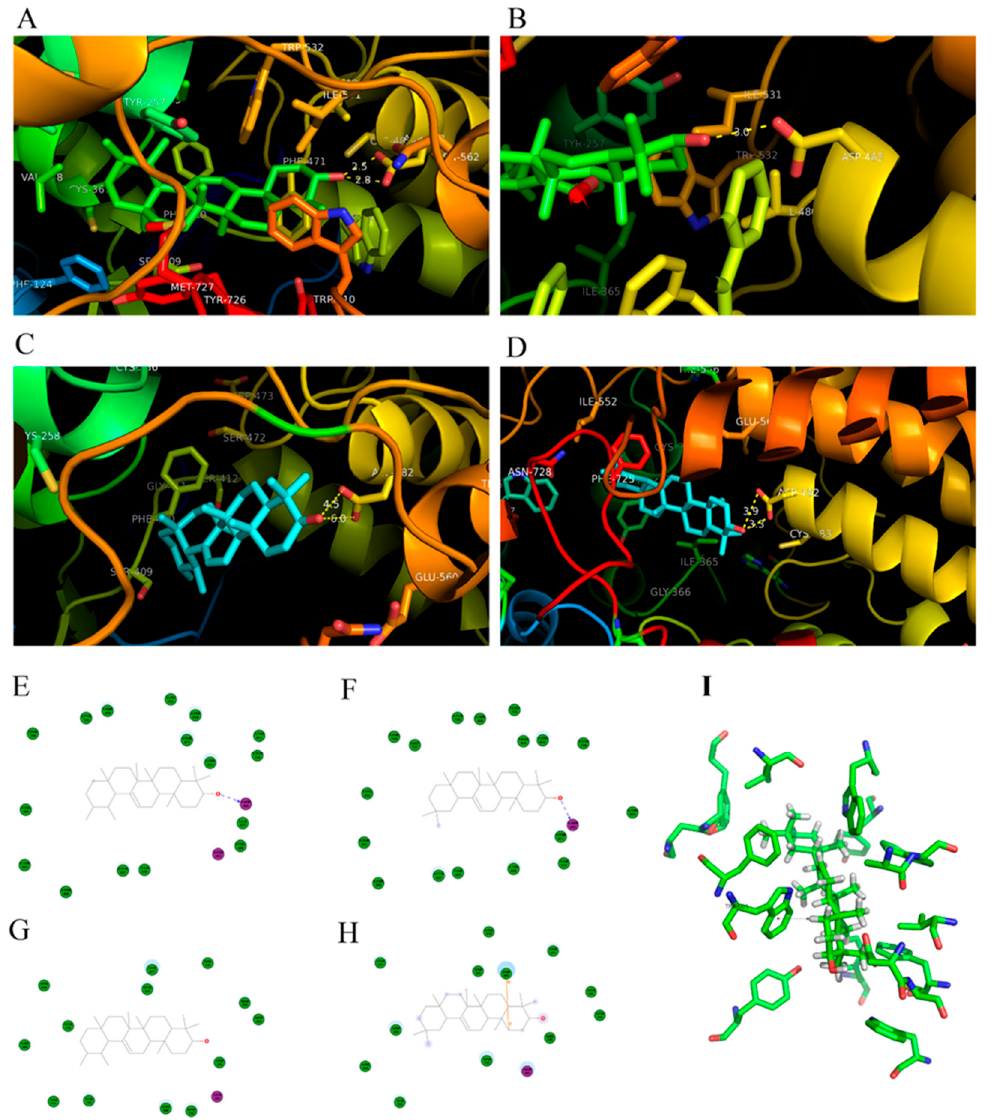
Figure 2. Molecular docking conformations and interactions between the enzyme and product for IaAS1_alpha ( A , E ), IaAS1_beta ( B , F ), IaAS2_alpha ( C , G ), and IaAS2_beta ( D , H , I ). The hydrogen bond donor and acceptor are colored as red and purple, respectively. Green and gray AA residues represent non-polar contact and any other contact, respectively. The first two AA residues were missing in the constructed structures; thus, the sequence number of AA residues is rearranged, i.e., ASP482 and TRP609 represent actual ASP484 and TRP611,